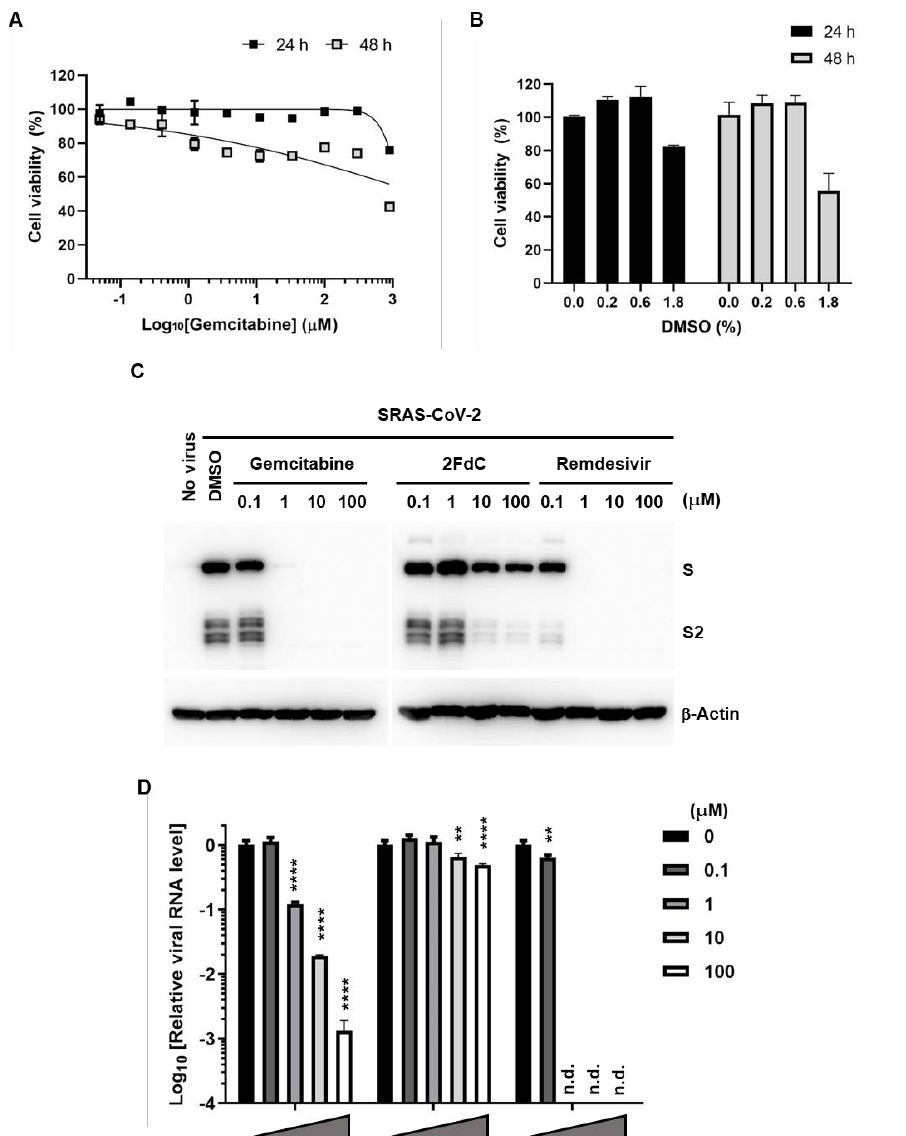
Figure 6. Reduction of viral S protein and viral RNA levels in Calu-3 cells by gemcitabine. ( A ) Cytotoxicity of gemcitabine to Calu-3 cells. Cells were treated with increasing concentrations of gemcitabine for 24 (black square) and 48 h (gray square). Percentage cell viability was measured by MTT assay, in which mock-treated cells served as a control (100%). ( B ) Effect of DMSO on cell viability. Increasing concentrations of DMSO, 0.2, 0.6 and 1.8% ( v / v ), that were identically included in 100, 300 and 900 µ M gemcitabine shown in ( A ), were treated to Calu-3 cells for 24 (black bars) and 48 h (gray bars) for cell viability assay. Values are means ± standard deviations from thee three independent experiments in ( A , B ). ( C ) Western blot of the S protein. Calu-3 cells in 6-well plates were mock-infected (No virus) or infected with SARS-CoV-2 at an MOI of 0.002 for 1 h at 37 ◦ C. Cells were treated with 10-fold increasing concentrations of gemcitabine, 2FdC, or remdesivir or with 0.2% DMSO. On the next day, cell lysates were subjected to 10% SDS-PAGE and immunoblotting. Full-length S and its cleaved product S2 were visualized using an S-specific antibody (upper panel), with β -actin serving as a loading control (lower panel). ( D ) Real-time RT-PCR was performed using culture supernatants from the same samples used in ( A ) by targeting the viral N gene. The RNA titer from virus-infected samples but not treated with any antiviral compound (DMSO) was used as a mock control. Changes in viral RNA level are depicted using a log scale. Values are means ± standard deviations from thee three independent experiments. Multiple comparisons were performed between each test group and the mock control group by two-way analysis of variance (ANOVA). ** p < 0.01; **** p < 0.0001. n.d., not